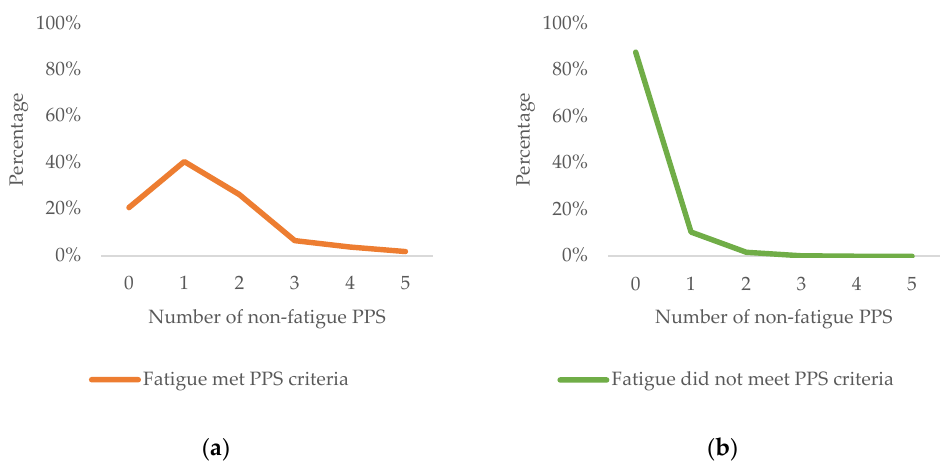
Figure 1. ( a ) Percentage of participants whose fatigue met PPS criteria and who met criteria for none, one or more non-fatigue PPS. ( b ) Percentage of participants whose fatigue did not meet PPS criteria and who met criteria for none, one or more non-fatigue PPS.